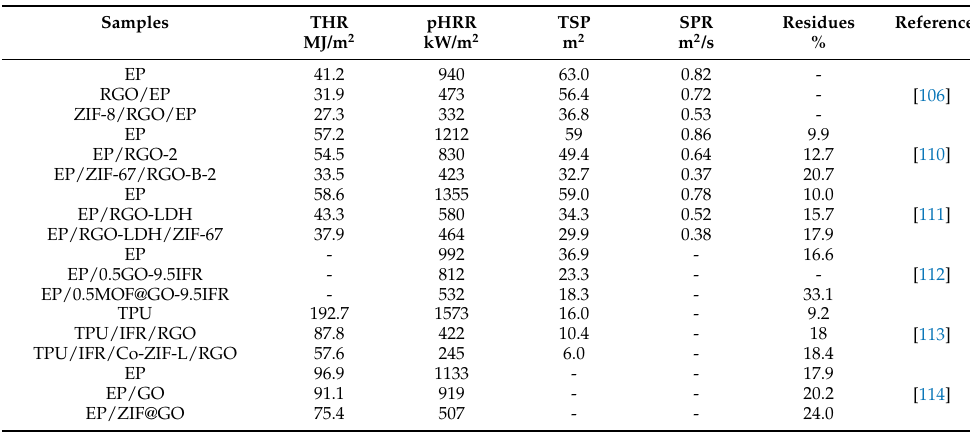
Table 3. Data on graphene and its compounding with MOFs as flame retardants.